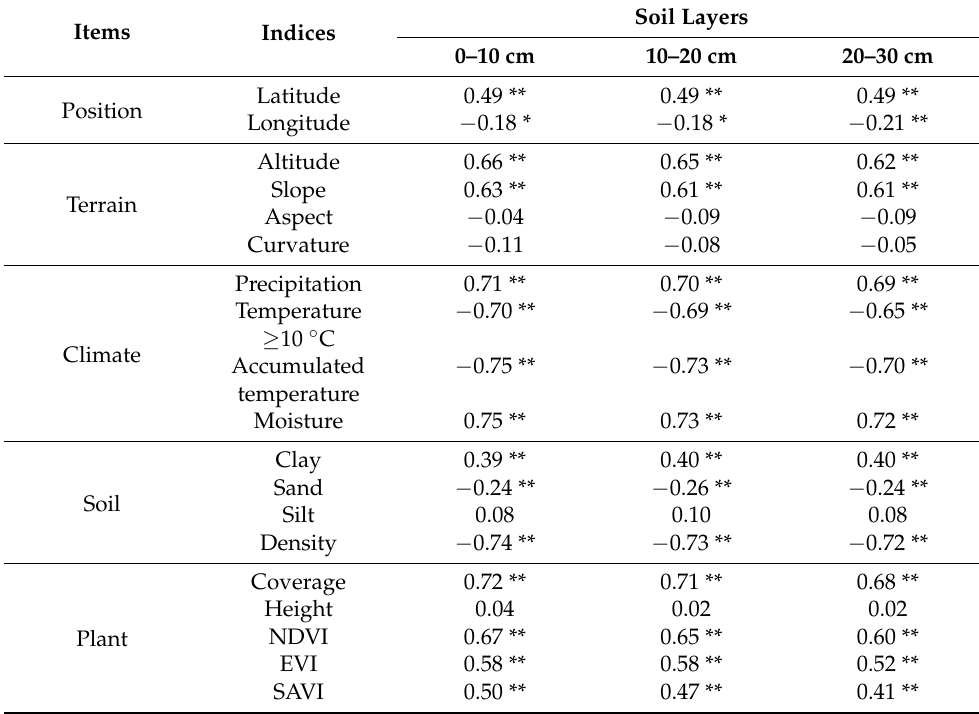
Table 1. Correlation coefficients (r) between grassland root biomass and ecological factors.